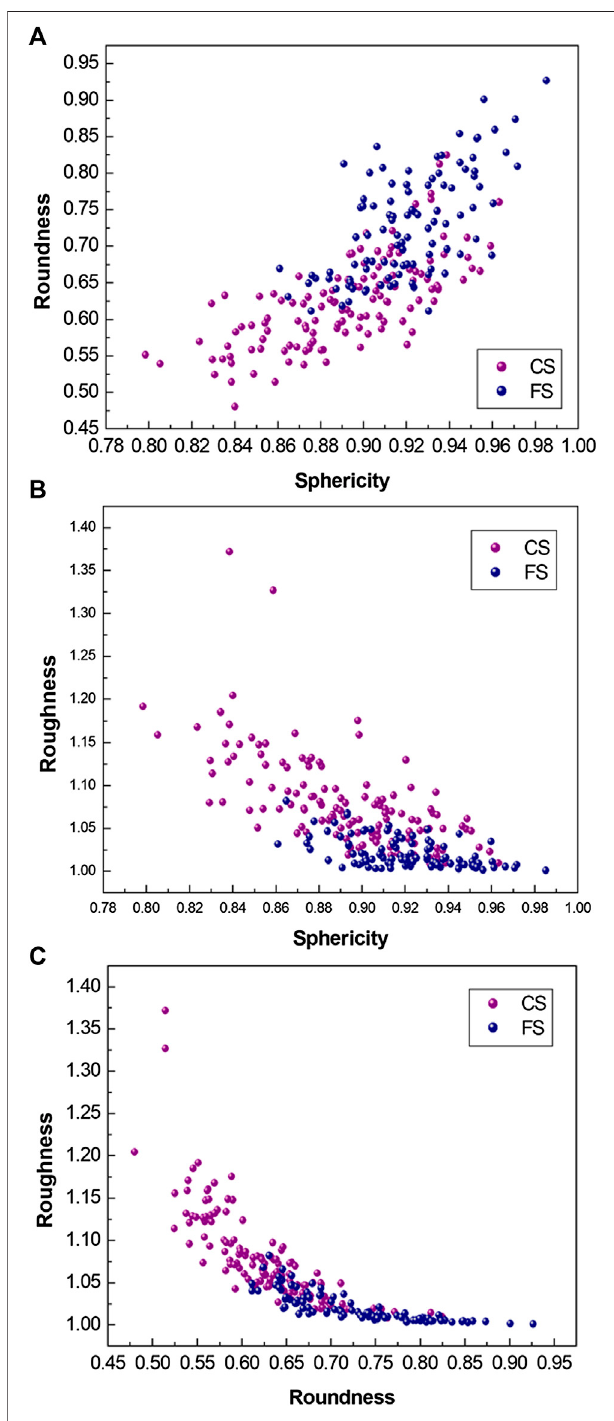
FIGURE 4 | Correlation between the multiscale morphological descriptors (A) sphericity plotted against roundness, (B) sphericity plotted against roughness, (C) roundness plotted against